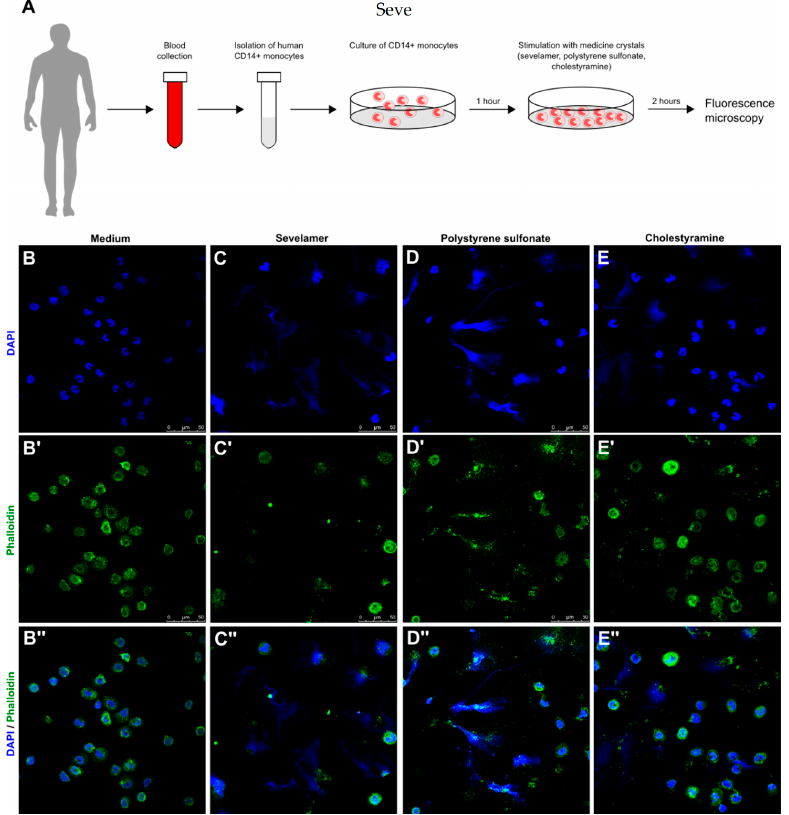
Figure 6. Crystals of ion-exchange resins induce extracellular trap formation in human CD14+ monocytes. ( A ) Schematic showing work flow. Human blood CD14+ monocytes were isolated from healthy individuals and stimulated with or without sevelamer, polystyrene sulfonate, or cholestyramine crystals (1000 µg/mL) for 2 h. ( B – E ) After stimulation, CD14+ monocytes were stained with DAPI (blue, stains nuclei) ( B – E ) and phalloidin (green, stains actin) ( B’ – E’ ) to visualize extracellular trap formation in response to sevelamer ( C ), polystyrene sulfonate ( D ), and cholestyramine ( E ) crystals or the medium (control) ( B ). Images are also shown as a merge of DAPI and phalloidin (200× magnification (B’’ – E’’ )).